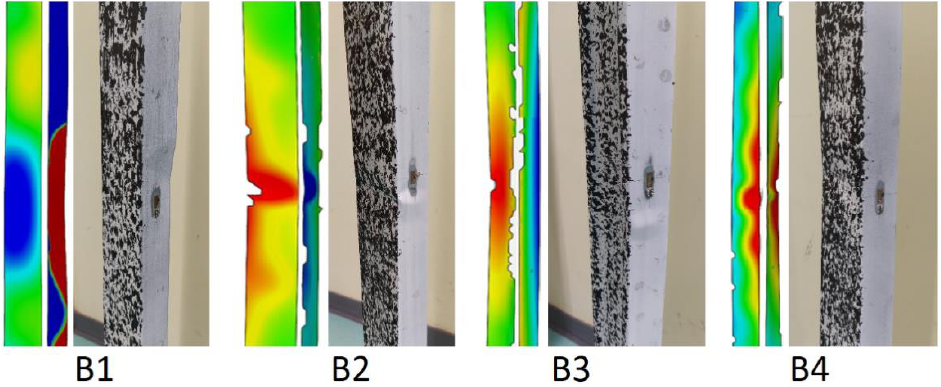
Figure 10. Forms of destruction of